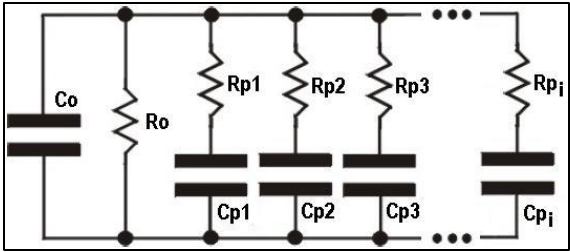
Figura 2: Modelo con los dipolos del aislamiento. Fuente: Autores, (2017).